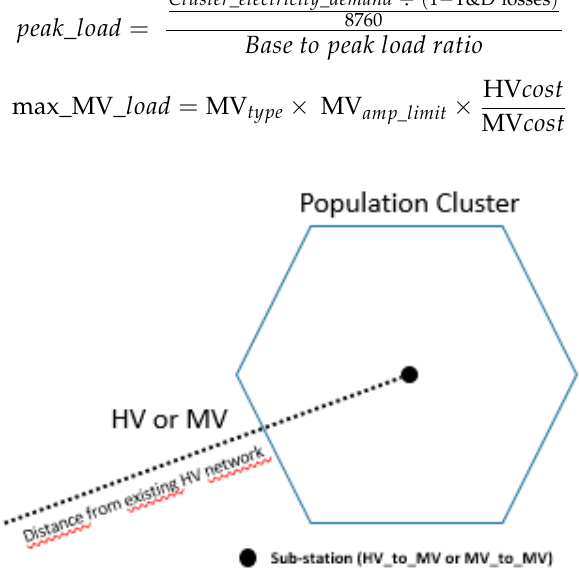
Figure A3. Estimating transmission line length from existing grid network.